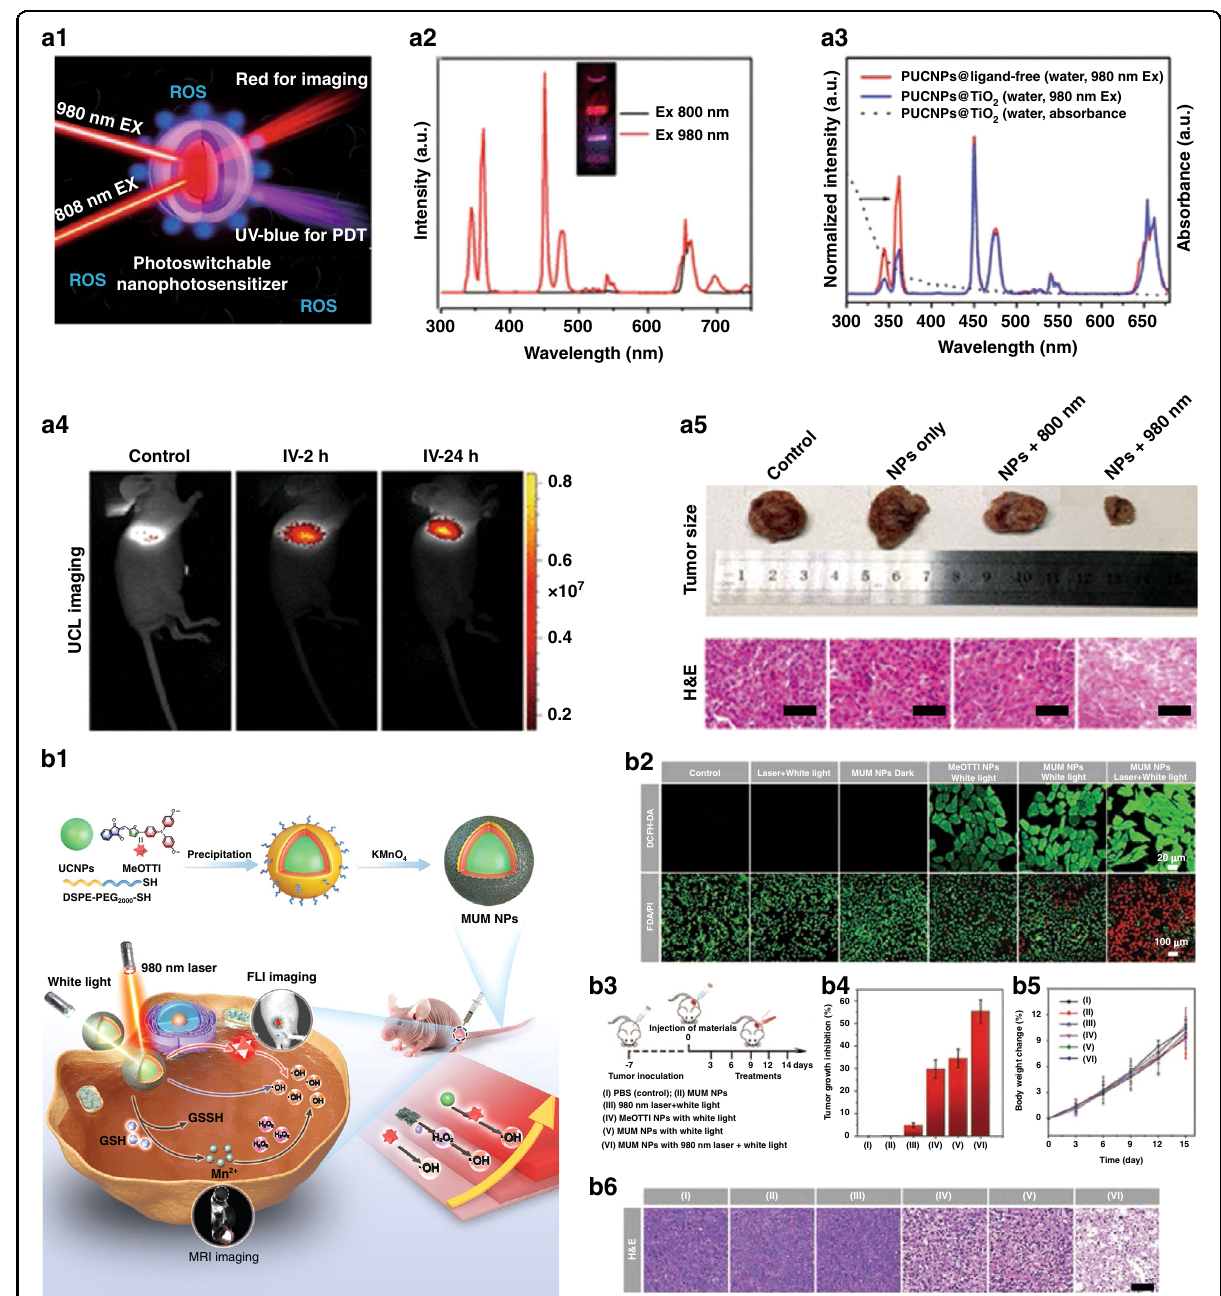
Fig. 7 Photodynamic therapy. a1 Schematic of PUCNPs@TiO 2 nanocomposites for imaging guided PDT. a2 Upconversion emission spectra of PUCNPs excited by 800 or 980 nm laser (5 W cm − 2 ). Inset: luminescence photograph of PUCNPs in cyclohexane under irradiation by two laser beams (0.8 W cm − 2 ). a3 UCL spectra of PUCNPs@ligand-free (red line) and PUCNPs@TiO 2 (blue line), the absorbance spectra of PUCNPs@TiO 2 (dotted line). a4 UCL imaging in LLC tumor-bearing mouse after intravenous injection of PUCNPs@TiO 2 for 2 and 24 h (800 nm irradiation). a5 The digital photographs of excised tumors after various treatments and H&E-stained slices of tumor tissues collected from different groups. The scale bars stand for 50 μ m 118 . b1 Schematic illustration of fabrication of MUM NPs and dual-modal imaging guided triple-jump PDT. b2 DCFH-DA assay for intracellular ROS level (upper row) and FDA/PI assay for live/dead cell staining (lower row) of 4T1 cells after different treatments. b3 Schematic diagram of the operation process of antitumor therapy. b4 Tumor inhibition ratios of different groups after various treatments on day 14. b5 Body weight pro fi les of mice under different treatments. b6 H&E staining analysis of tumor tissues collected from different groups 127 . a1 – a5 Reprinted with permission from ref. 118 Copyright 2018, American Chemical Society. b1 – b6 Reprinted with permission from ref. 127 Copyright 2021,